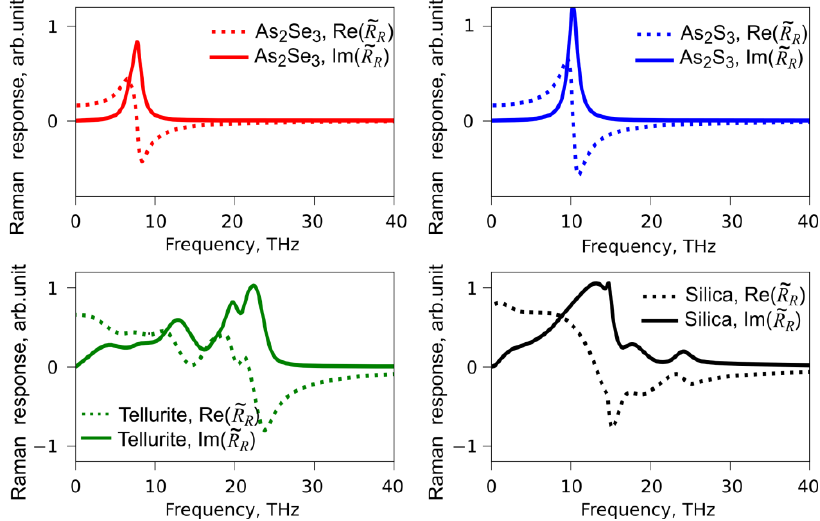
Figure 1. Real and imaginary parts of model Raman response functions in the frequency